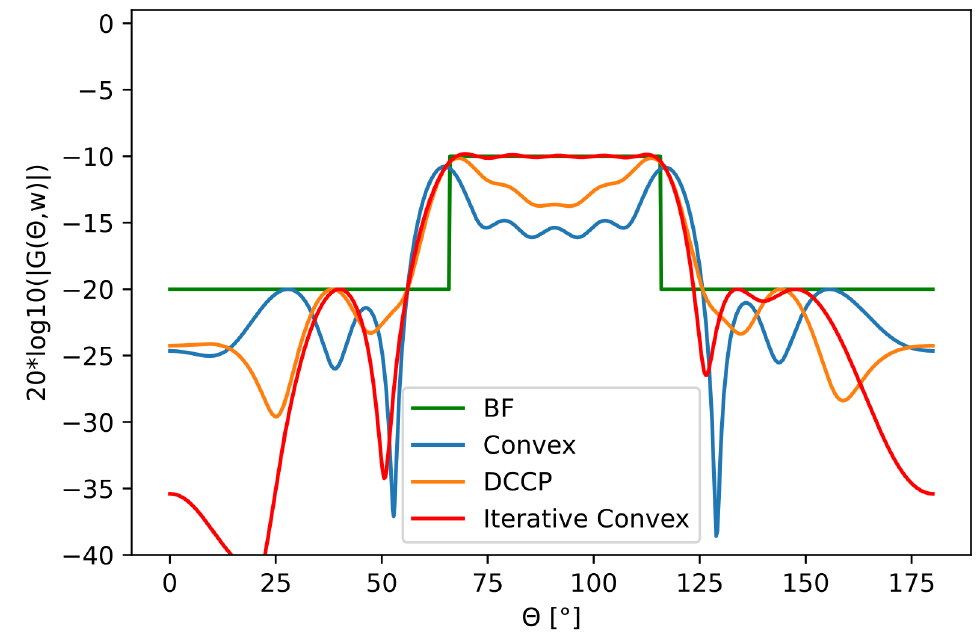
Figure 6. Uniform rectangular wide beampattern transmission mask in a 50 ◦ interval together with optimized